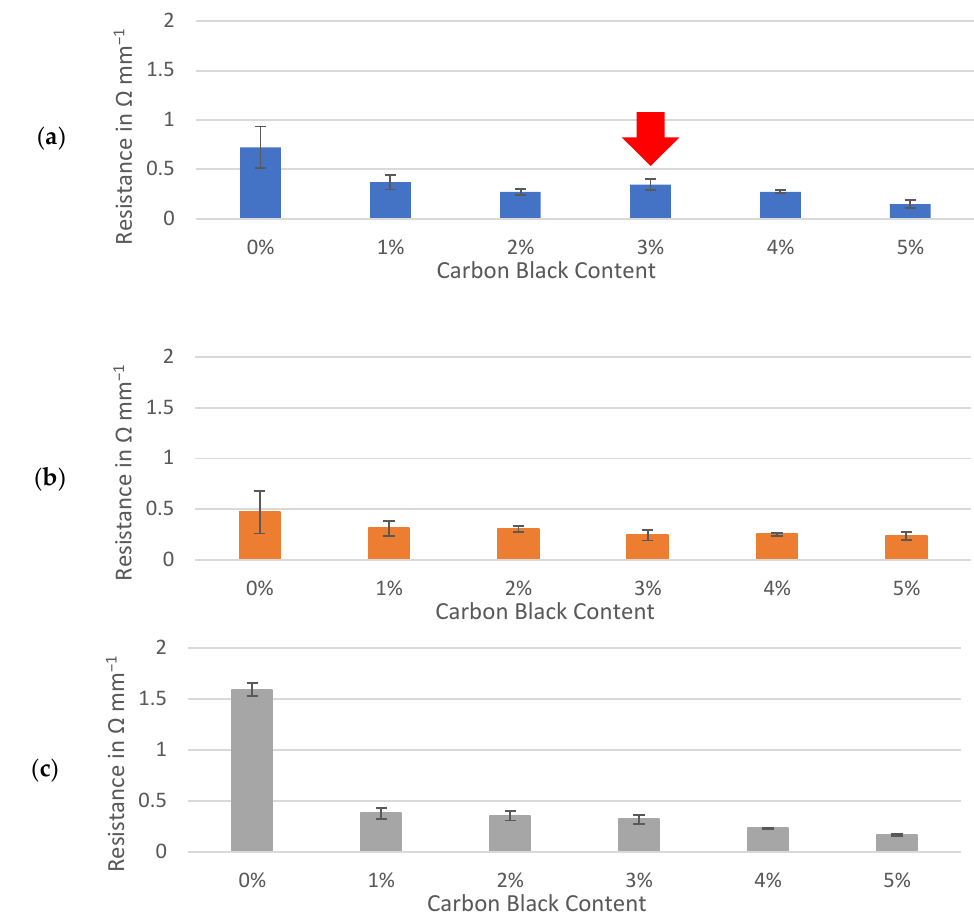
Figure 4. Through-resistance of: ( a ) Kuranode; ( b ) MTI hard carbon and ( c ) graphite electrode slabs on current collector foil. The error bars indicate the standard deviations.